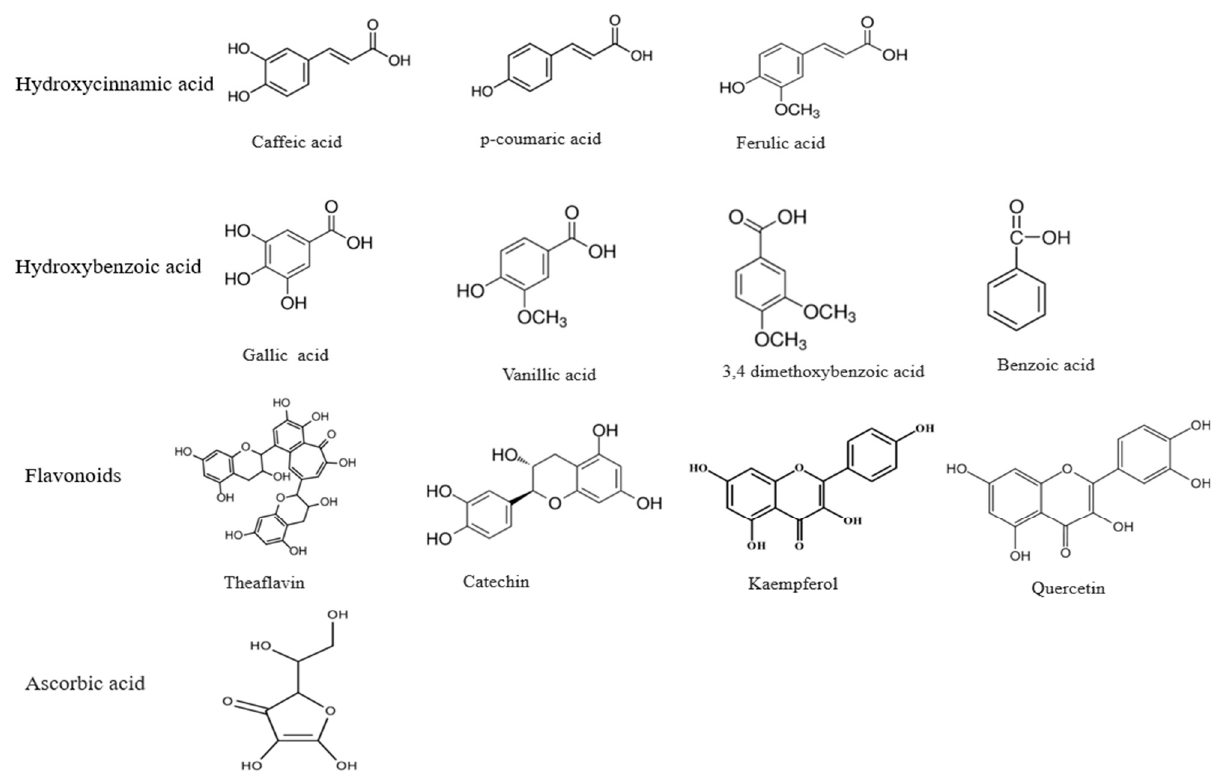
Figure 1. Some important polyphenolic compounds.